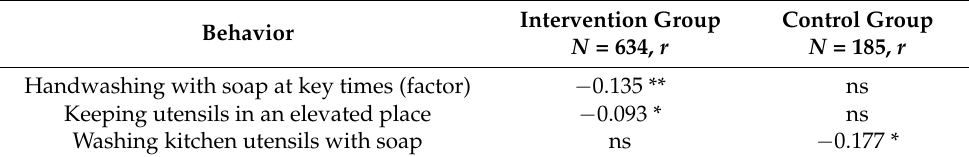
Table 3. Pearson correlation of target behaviors with mental health condition of the study participants: intervention and control group. Intervention Group Control Group Behavior N = 634, r N = 185, r Handwashing with soap at key times (factor) − 0.135 ** Keeping utensils in an elevated